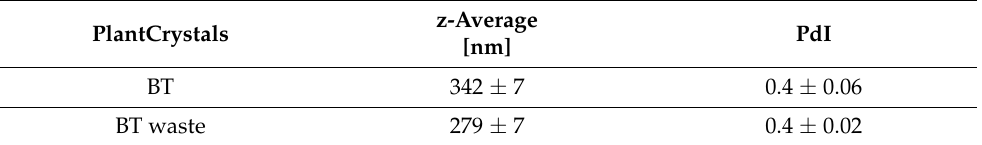
Table 2. Dynamic light scattering (DLS) data showing z-average and the polydispersity index (PdI) of the produced PlantCrystals of black tea (BT) leaves and their waste. z-Average PdI PlantCrystals [nm] BT 342 ± 7 0.4 ± 0.06 BT waste 279 ± 7 0.4 ±